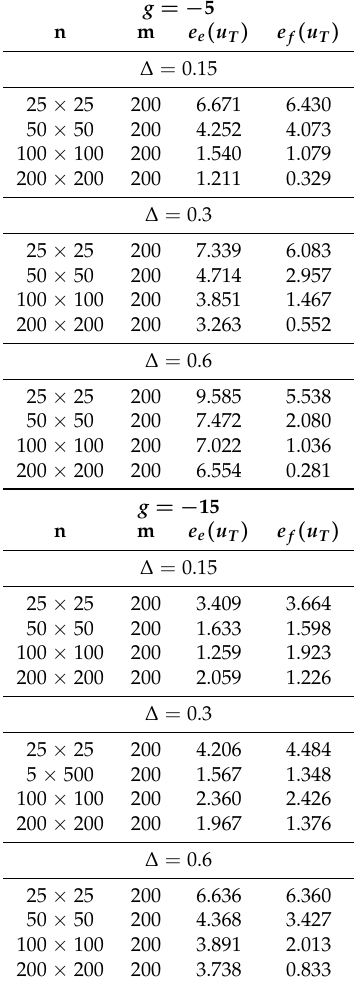
Table 4. Two-dimensional problem with erf-smoothing. Relative L 2 error for the temperature at the final time with respect to the finest grid solution using the presented method ( e f ( u T ) ) and h-smoothing ( e e ( u T ) ). g = − 5